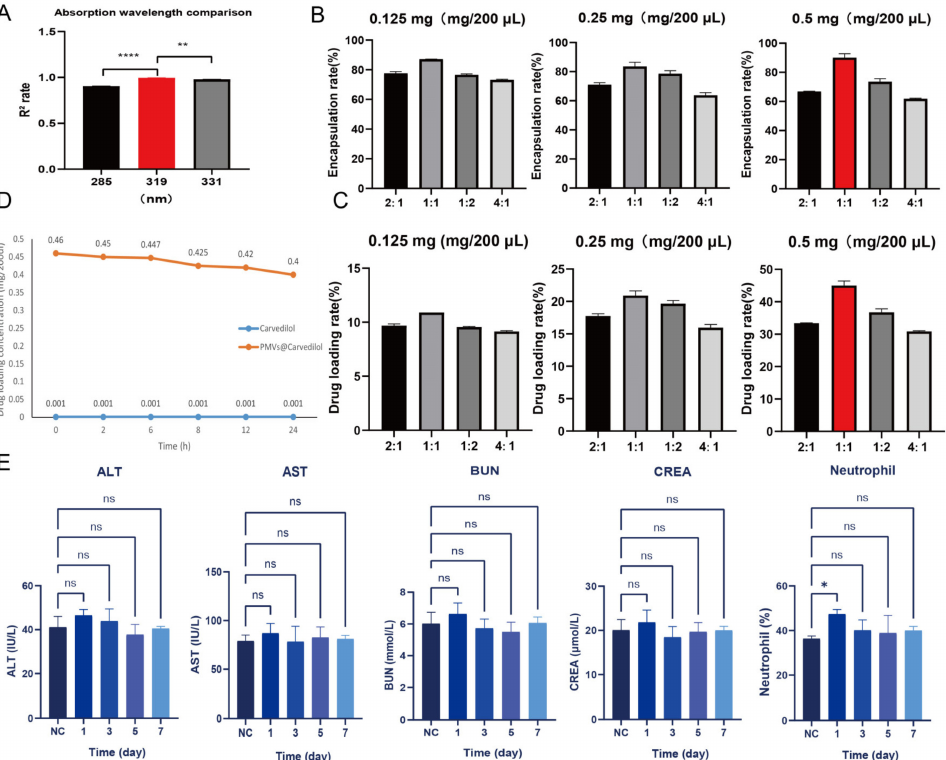
Figure 4. Determination of optimal drug encapsulation and loading rate for PMVs@Carvedilol and validation of toxicity in vivo. ( A ) Comparison of the maximum absorption of Carvedilol at 285 nm, 319 nm, 331 nm. ( B ) Comparison of the encapsulation rate at different concentrations and volume ratios. ( C ) Comparison of the drug loading rate at different concentrations and volume ratios. ( D ) Changes in the encapsulation concentration of PMVs@Carvedilol at different time points (0 h, 2 h, 6 h, 8 h, 12 h, 24 h). (n = 3) ( E ) Analysis of various blood parameters of normal rats at different time periods after tail vein injection of PMVs@Carvedilol. * p < 0.05; ** p < 0.01; **** p <